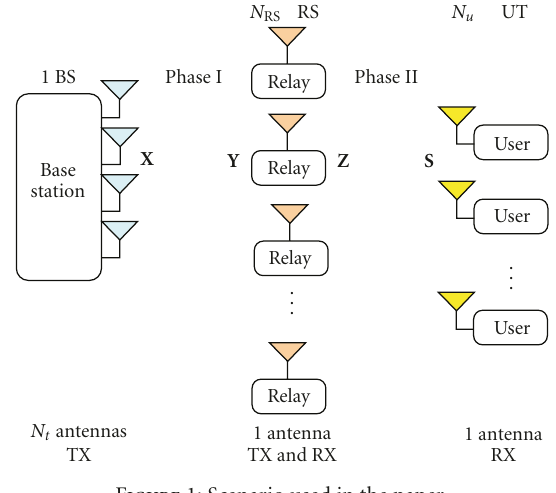
Figure 1: Scenario used in the